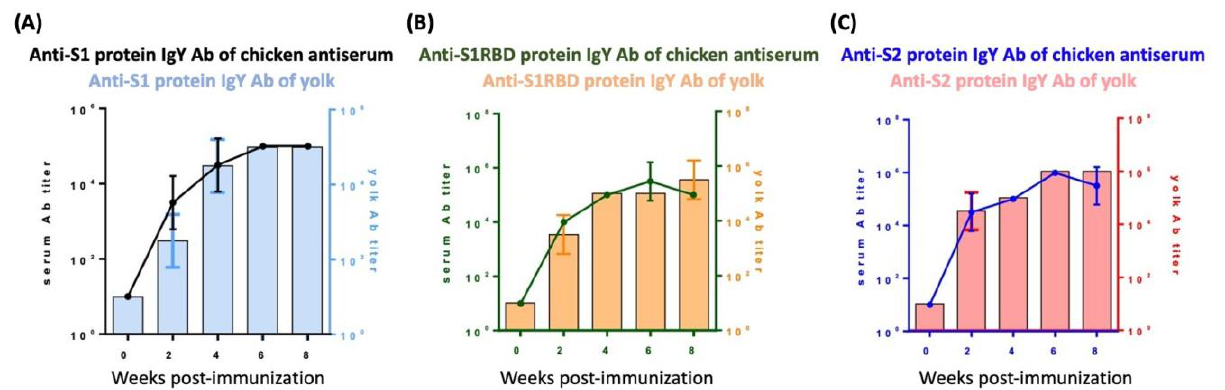
Figure 1. Detection of antibody titers in chicken and egg yolk anti-sera after immunization of laying hens. After immunizing laying hens with antigens derived from the S1, S1-RBD, or S2 subunits of the SARS-CoV-2 S protein, IgYs were collected from hens or egg yolks and IgY titers were specifically detected using ELISA. Increases in IgY titers for the ( A ) S1 subunit, ( B ) S1-RBD subunit, and ( C ) S2 subunit at different time points post-immunization are shown. In each panel, the line graph represents the time-course of the chicken IgY titer, and the bar graph represents the egg yolk IgY titer. Data are expressed as mean ± SD of 3 immunized hens and the egg yolk from 3 immunized eggs from each time point, respectively.